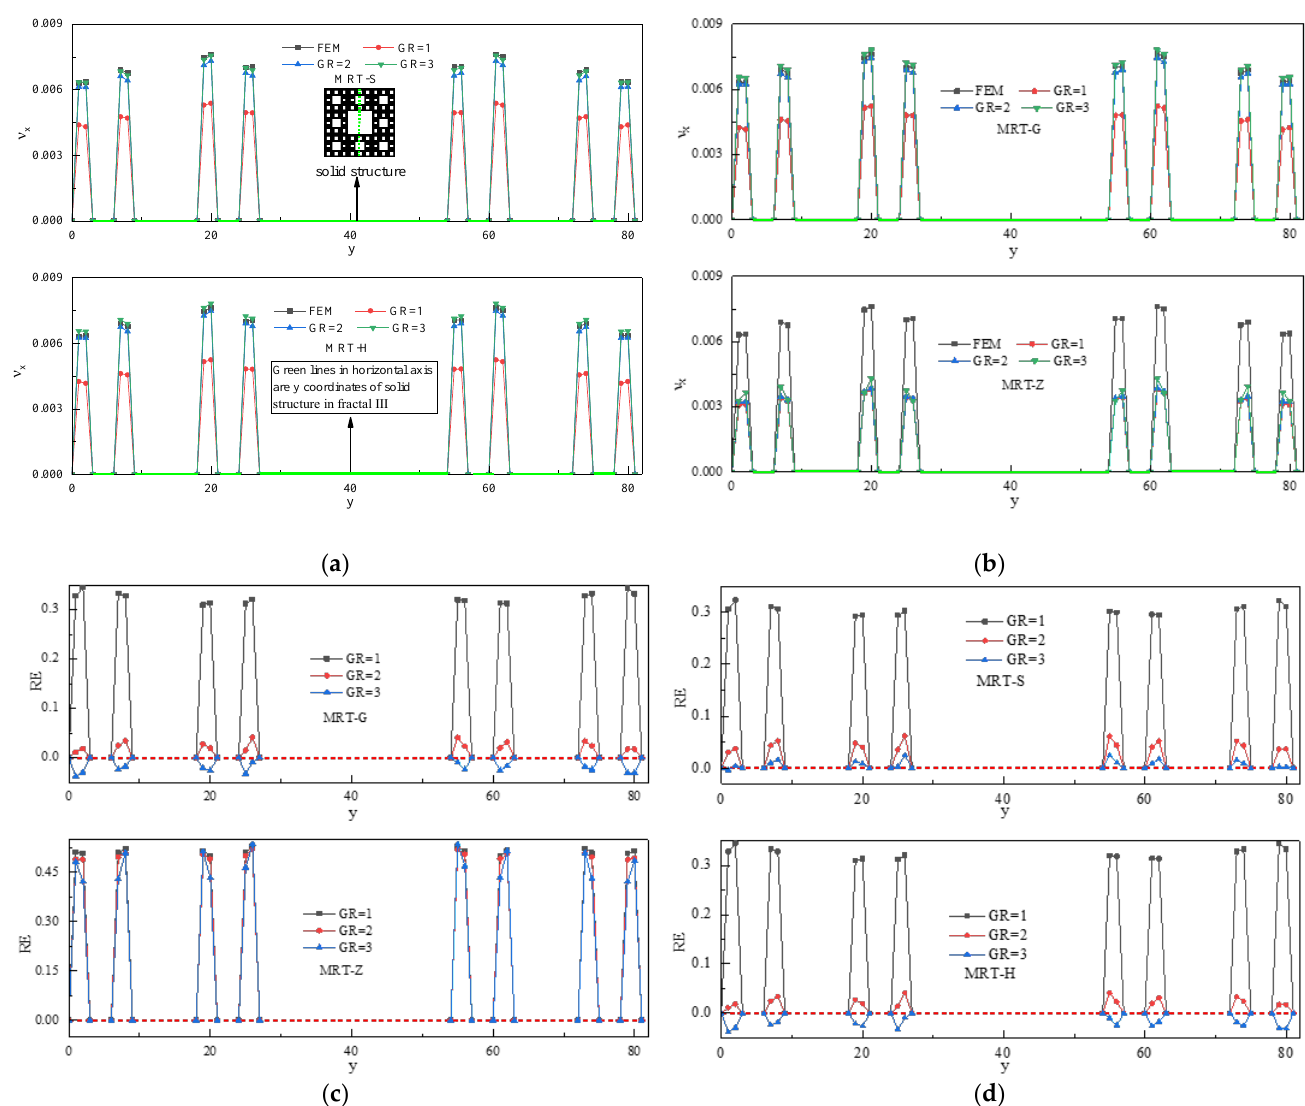
Figure 8. ( a , b ) The profiles of v x along vertical centerline of ROI (x = 140.5) in fractal III; ( c , d ) RE curves of v x along vertical centerline of ROI (x = 140.5) in fractal III.